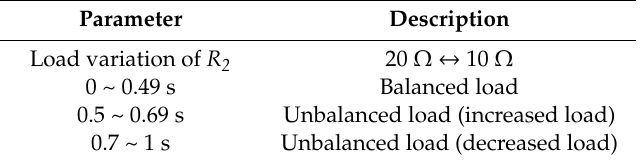
Table 3. Load variation